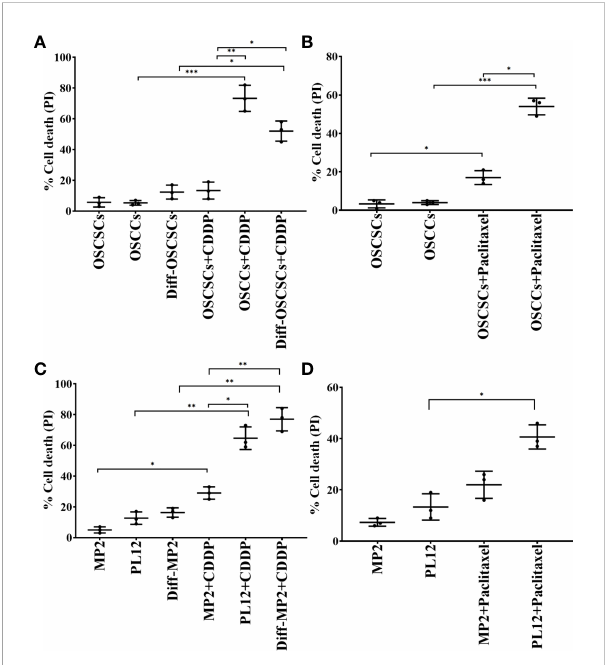
FIGURE 3 Increased susceptibility of differentiated oral and pancreatic tumor cell lines to chemotherapeutic drugs in comparison to their stem- like counterparts. OSCSCs were differentiated using supernatants from IL-2 (1000 U/ml) and anti-CD16 mAbs (3µg/mL) treated primary NK cells as described in Materials and Methods section. OSCSCs, OSCCs and NK-diff-OSCSCs were treated with cisplatin (60 µg/mL) for 18-20 hours, after which, the cells were stained with propidium iodide (PI) to determine percent cell death using fl ow cytometric analysis (n=3) (A) . OSCSCs and OSCCs were treated with paclitaxel (40 µg/mL) for 18-20 hours, after which, the cells were stained with PI to determine percent cell death using fl ow cytometric analysis (n=3) (B) . MP2 cells were treated with supernatants from IL-2 (1000 U/ml) and anti-CD16 mAbs (3µg/mL) treated primary NK cells in order to induce differentiation as described in the Materials and Methods section. MP2, PL12, and NK-diff-MP2 cells were treated with cisplatin (60 µg/mL) for 18-20 hours, after which, the cells were stained with PI to determine percentage of cell death using fl ow cytometric analysis (n=3) (C) . MP2 and PL12 tumor cells were treated